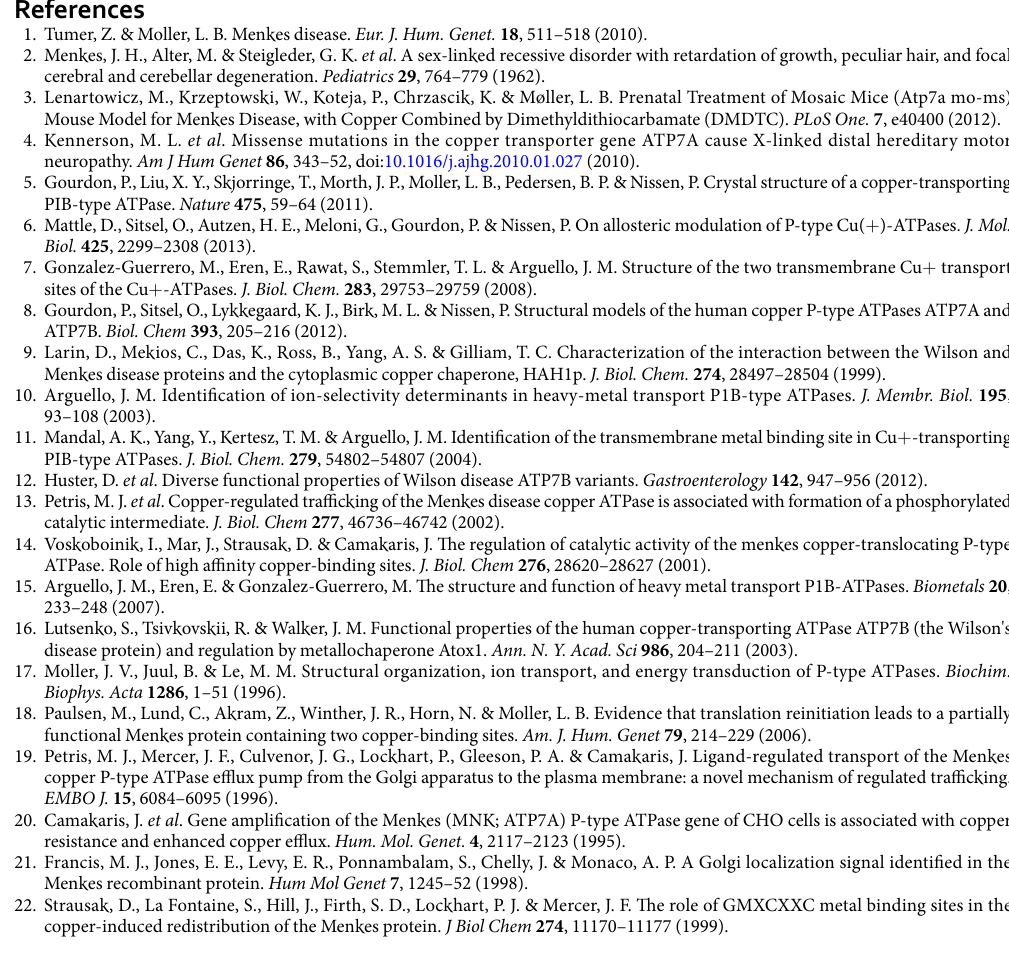
Yeast expression plasmids and complementation